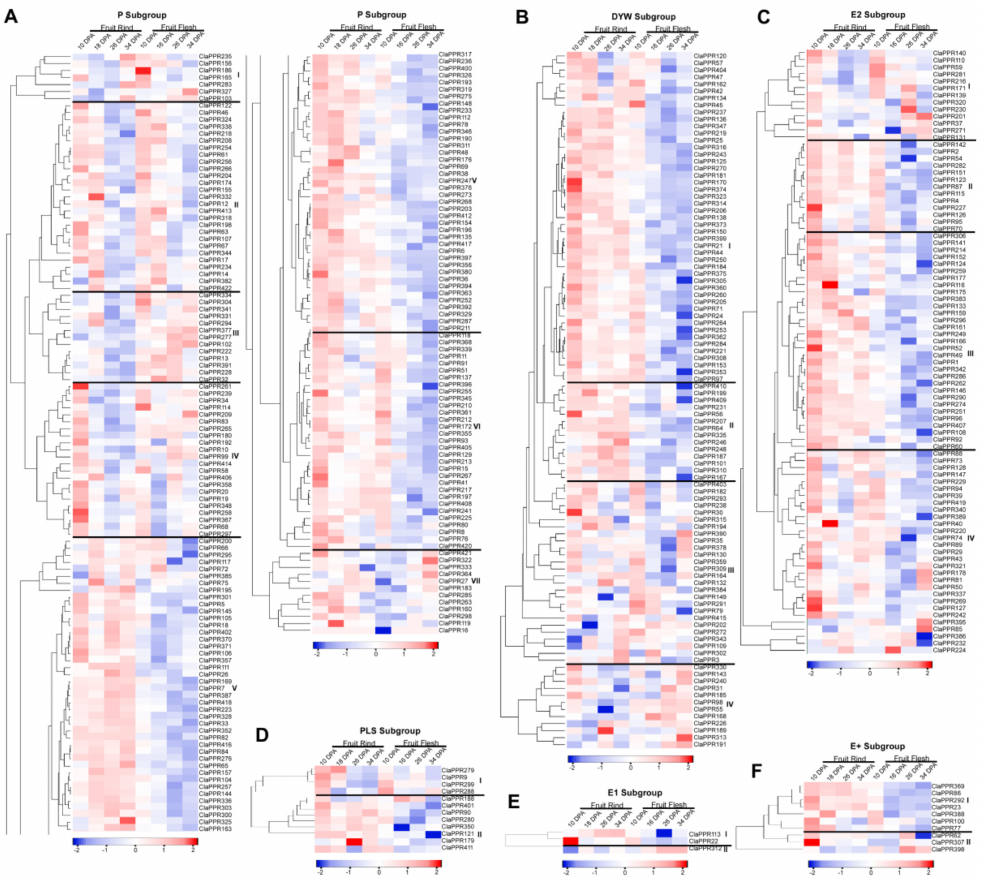
Figure 5. Expression profiles of ClaPPR genes during watermelon fruit development (Cultivar 97103; BioProject: SRP012849). All heat maps showing various expression levels of ClaPPR genes and subdivided into various clusters (labeled as roman numerals) were built using log2- transformed FPKM values of fruit rind and flesh at the developmental stages of 10, 18, 26, and 34 days after pollination (DAP). ( A ) Expression profiles of ClaPPR genes in the P subfamily, ( B – F ) Expression profiles of ClaPPR genes in the PLS subfamily and subgroups ( B ) DYW, ( C ) E2, ( D ) PLS, ( E ) E1, and ( F ) E + . Di ff erences in transcript abundances such as high (red) and low (blue) levels are shown in color as the scale bar of Z